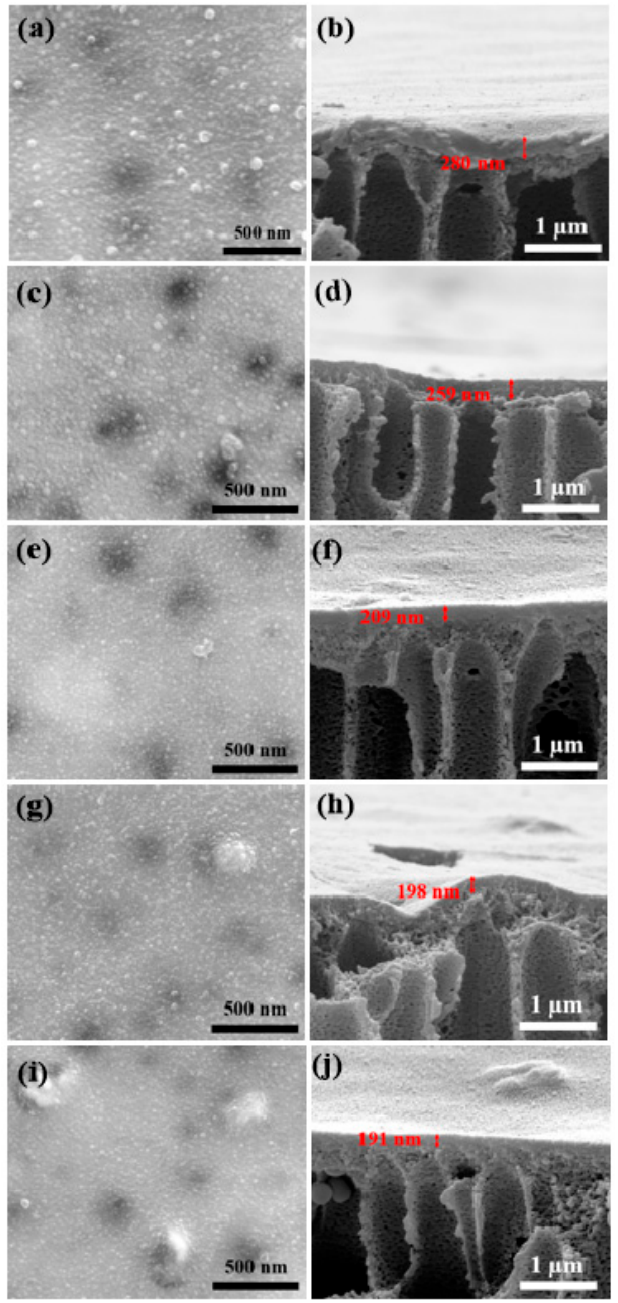
Figure 5. Surface and cross-sectional images of PA membranes on various supports ( a , b ) M-0, ( c , d ) M-0.05, ( e , f ) M-0.1, ( g , h ) M-0.15, and ( i , j ) M-0.2.